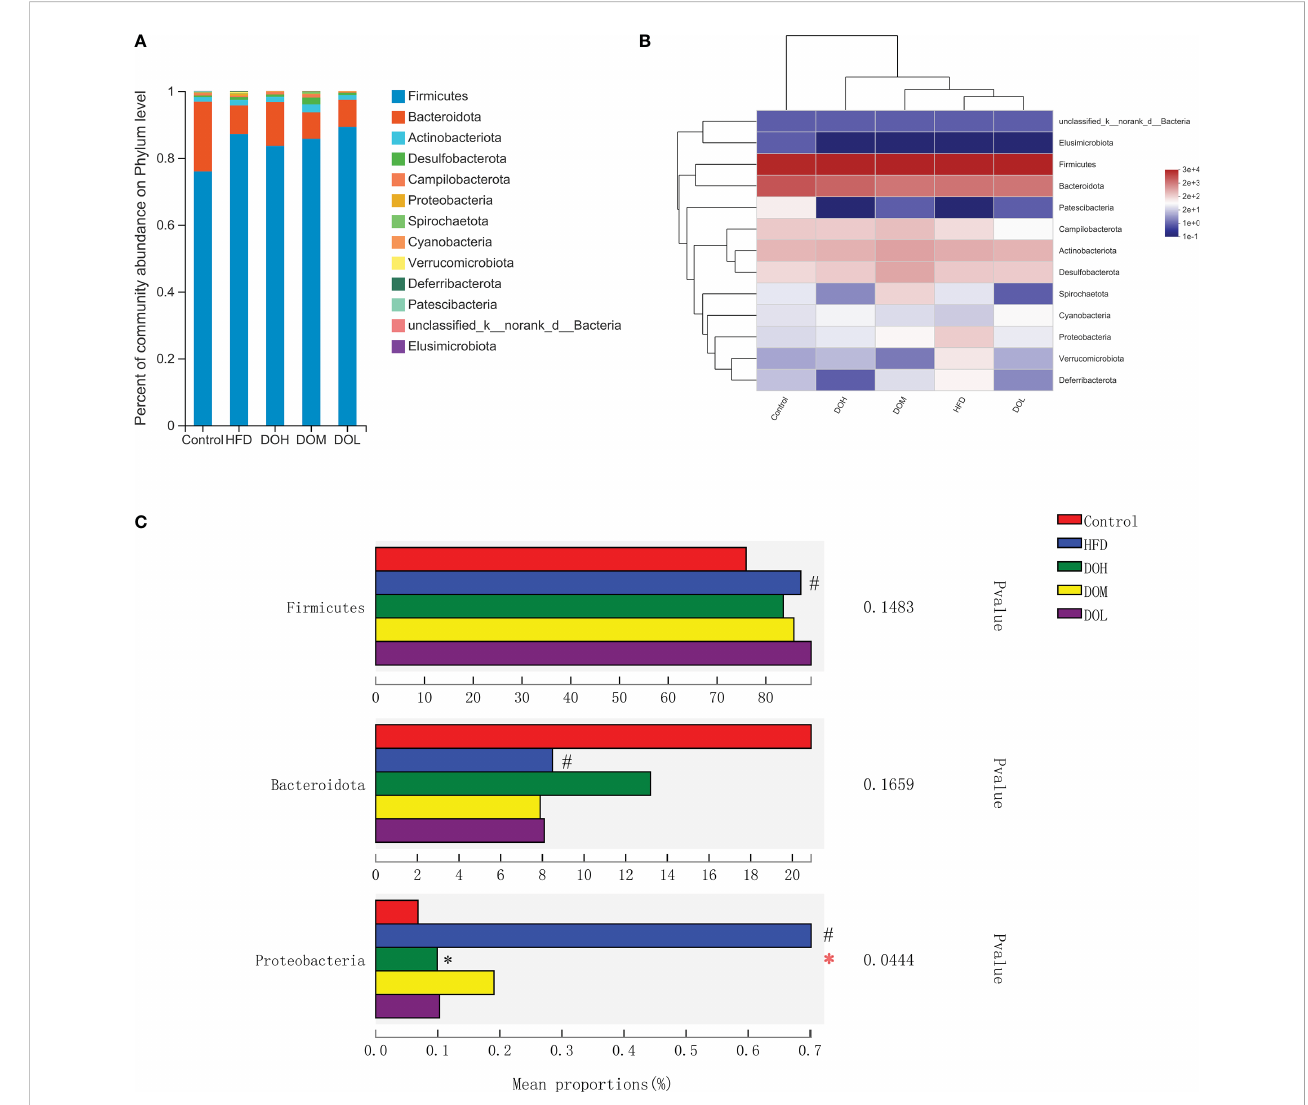
FIGURE 4 DO treatment modulated the gut microbiota composition at the phylum level. (A) Community abundance at the phylum level (%); (B) heat map of cluster stacking at the phylum level; (C) the relative abundances of Firmicutes, Bacteroidetes, and Proteobacteria. Data are expressed as the mean ± SD (n=6). # p < 0.05 vs. the Control group; * p < 0.05 vs. the HFD